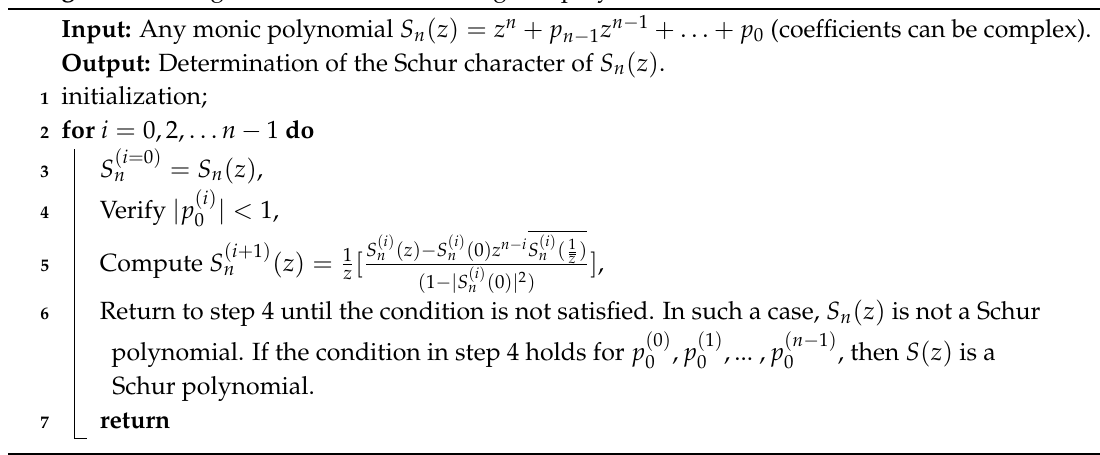
Algorithm 1: Algorithm to determine if a given polynomial is